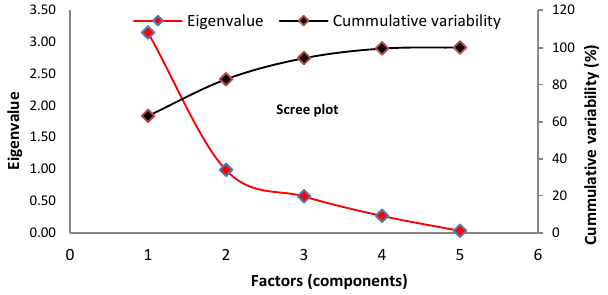
Figure 4: Box and whisker plots of selected plant extracts on reduction of mite